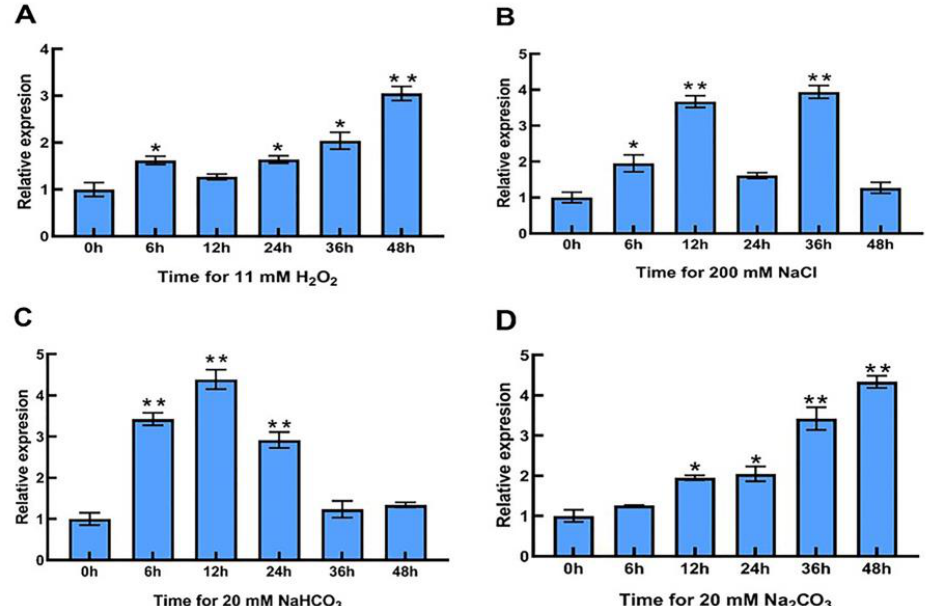
Figure 2. Expression characteristics of LpPsbP gene in the leaves of L. pumilum after stress treatment. The RNA in the leaves was extracted and then reverse-transcribed into cDNA and the levels of relative expression are gained through qRT-PCR. “*” indicates significant difference, Student’s t -test (P<0.05, ± SEM). “**” indicates extremely significant difference. ( A ): Expression of LpPsbP gene at 11 mM H 2 O 2 treatment at different times. ( B ): Expression levels of LpPsbP gene at 200 mM NaCl treatment at different times. ( C ): Expression levels of LpPsbP gene at 20 mM NaHCO 3 treatment at different times. ( D ): Expression levels of LpPsbP gene at 20 mM Na 2 CO 3 treatment at different times.